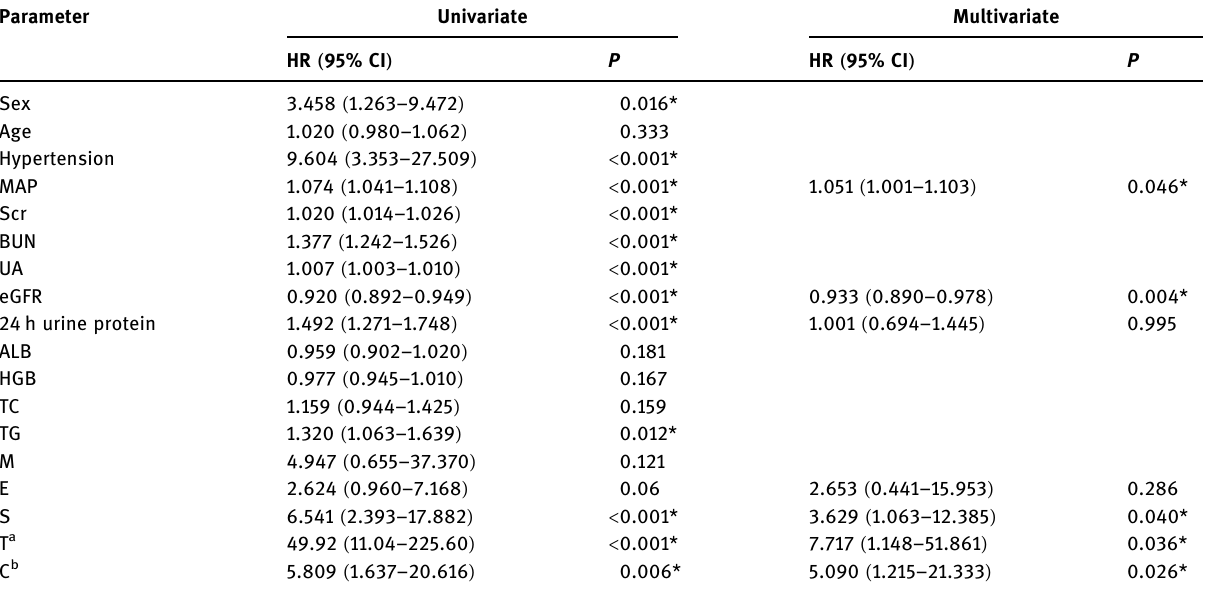
Table 4: Cox regression analysis of prognostic factors for patients with IgAN